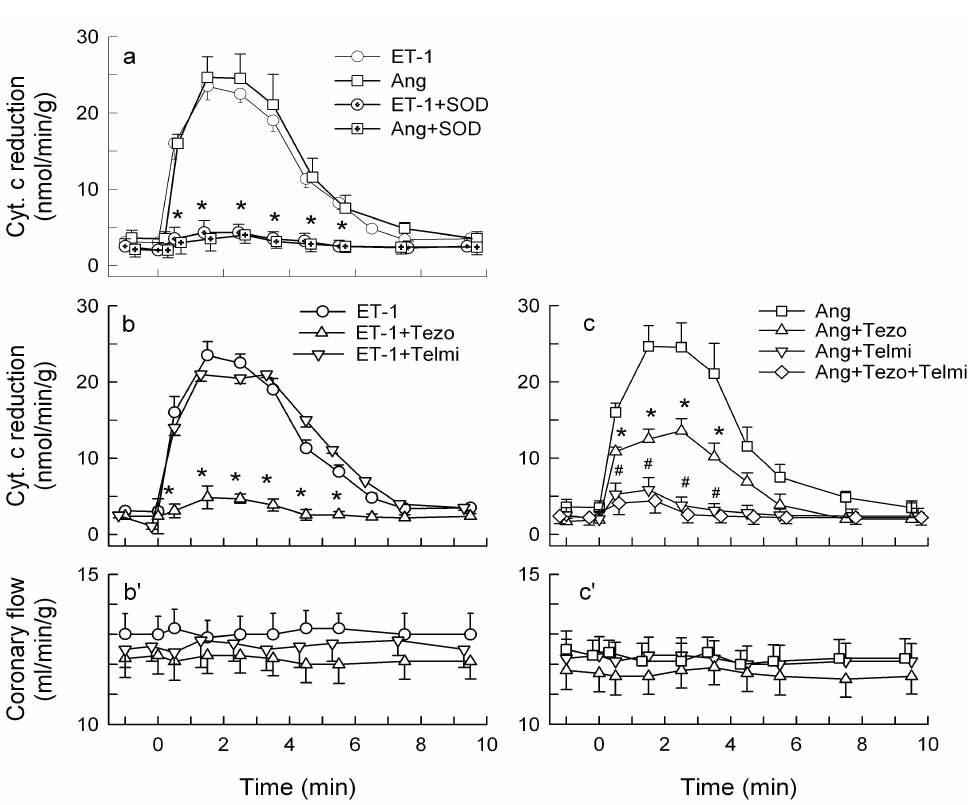
Figure 1. Outflow of reduced cytochrome c ( a – c ) and coronary flow ( b' – c' ) in guinea-pig hearts stimulated with endothelin-1 (ET-1, 25 pM) and angiotensin II (Ang, 20 nM). ( a ) ET-1 and Ang given either alone or in combination with 150 IU/mL SOD; ( b – b' ) ET-1 alone and combined with 5 nM tezosentan or 7.5 μ M telmisartan; ( c – c' ) Ang alone, combined with tezosentan, telmisartan or tezosentan + telmisartan. Values are means ± SEM of at least five experiments. * p < 0.05 vs. ET-1 and Ang group, respectively; # p < 0.05 vs. Ang + Tezo